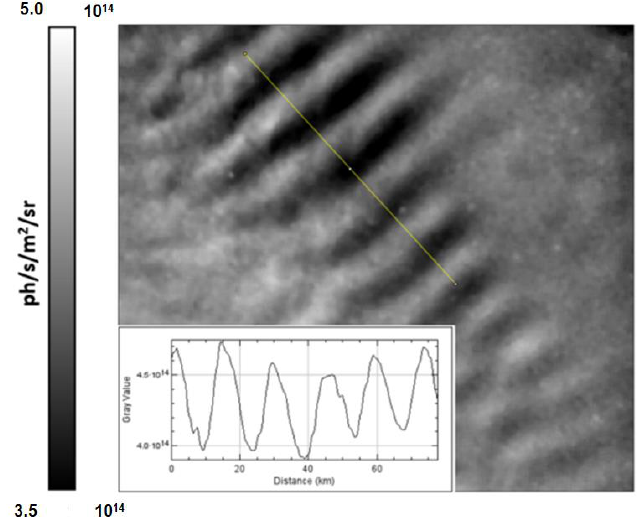
Figure 6. Retrieval of GW horizontal wavelength with ImageJ from GW patterns observed on a corrected radiance nightglow image (photons/s/m 2 /sr) on the night of 10 October 2017 at 2209 UTC. Bottom left, the intensity profile along the yellow line gives approximately a horizontal wavelength of 13 km between two peaks of intensity.